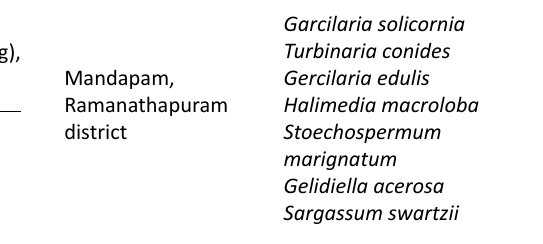
Table 2. Seaweeds collected from Mandapam,